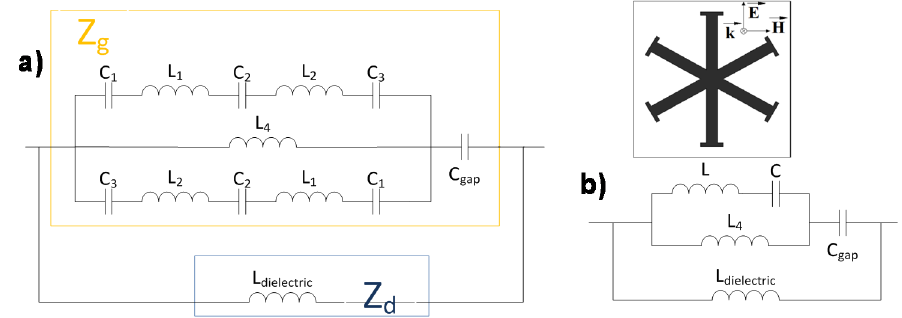
Figure 6. TM polarization: ( a ) Equivalent circuit; ( b ) Simplified